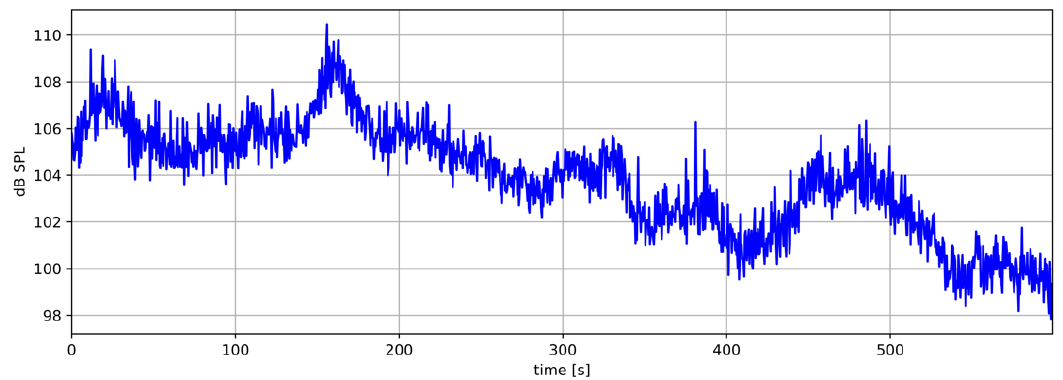
Figure 5. Graph of sound pressure level (SPL) as a function of time produced automatically by the system. Combining the narrowband spectrum into ANSI third octave bands and averaging on the whole 10 min period, we obtain the one-third octave bands values (Figure 6).